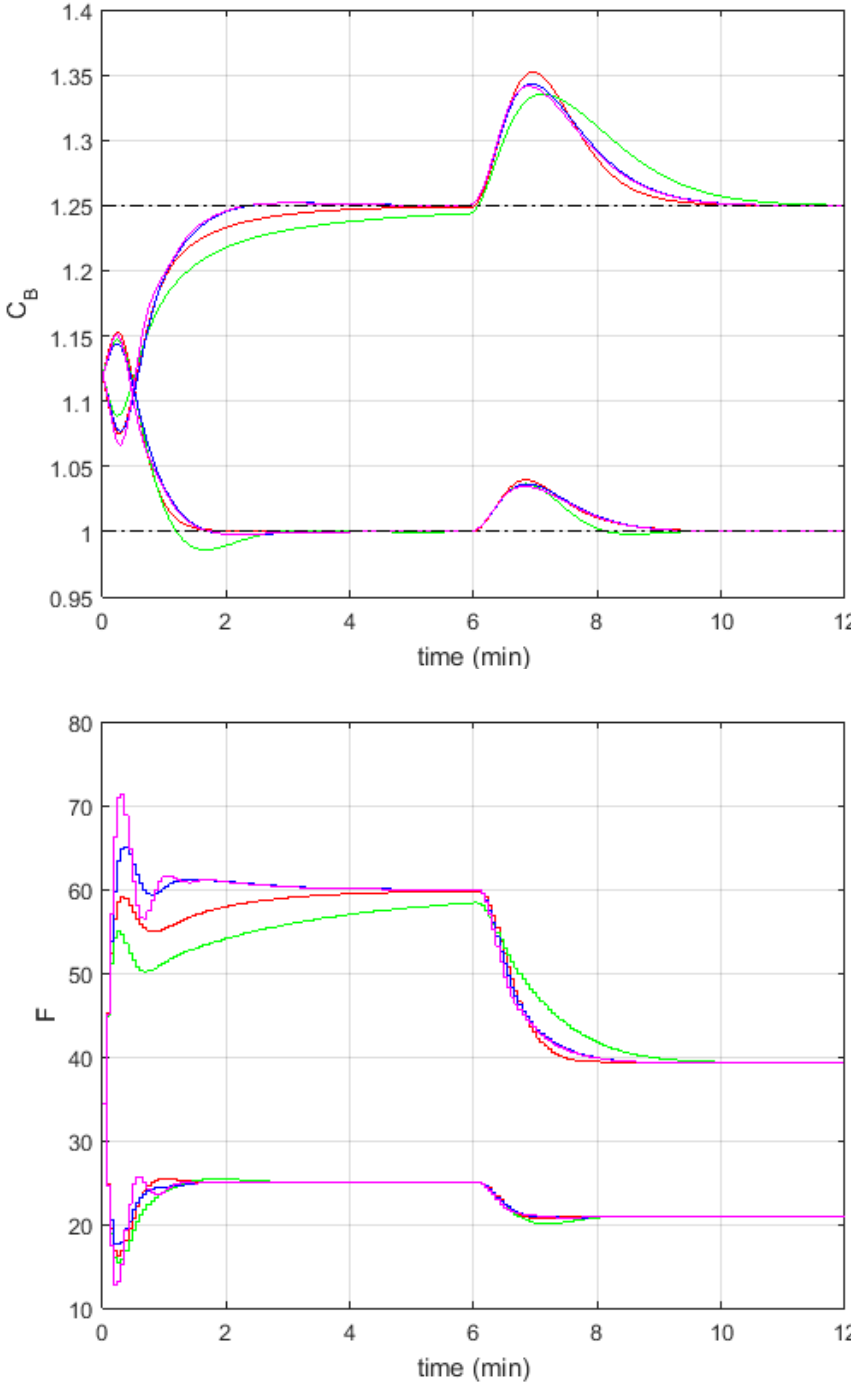
Figure 4. Responses of the control system to changes in the setpoint to C B 1 = 1 mol/L and C B 2 = 1.25 mol/L and to the change of the disturbance by 10% in the 6th minute of the experiment; λ = 0.0001; NMPC—red lines, LMPC—green lines, FMPC1—blue lines, FMPC2—magenta